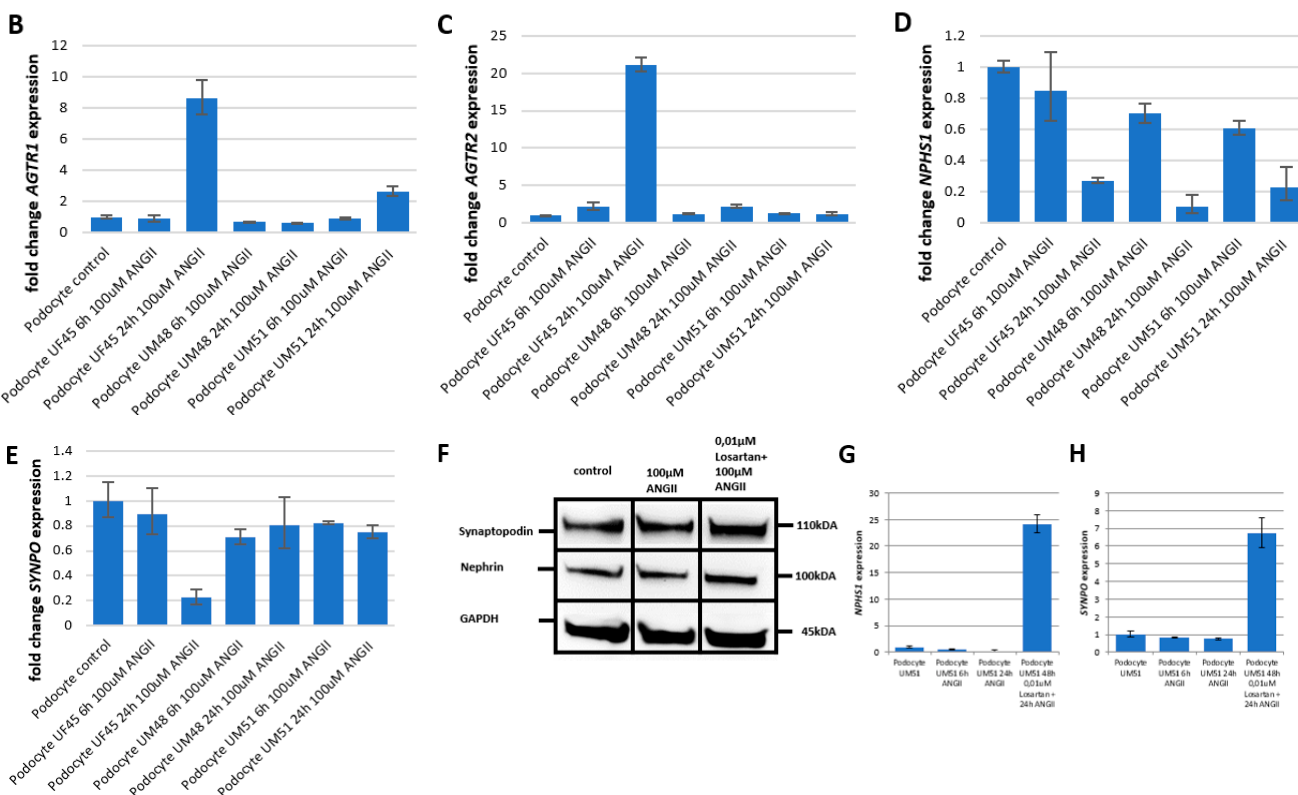
Figure 4. Dynamic changes in the morphology of human urine-derived podocytes post treatment with angiotensin II (ANGII) after 6 h and 24 h and is rescued by losartan. UdRPC-differentiated podocytes from UF45, UM48, and UM51. The top panel (phase contrast) shows the typical “fried egg” shaped podocyte morphology. The lower two panels show morphology changes after 6 h of 100 µM ANGII treatment. Podocyte cytoskeleton was visualized by immunofluorescence-based detection of α -actinin in red ( A ). ANG II interferes with the cytoskeleton of the podocytes, inhibiting podocyte spreading and leading to the observed roundish phenotype. Expression of ANGII receptors AGTR1 ( B ), and AGTR2 ( C ) and expression podocyte markers NPHS1 ( D , G ) and SYNPO ( E , H ) were determined by quantitative real-time PCR normalized with the ribosomal encoding gene-RPL0. An overview of the KEGG-annotated renin–angiotensin system is given in Supplementary Figure S5. Expression of podocyte markers nephrin and synaptopodin was determined by Western blot-based detection ( F ).